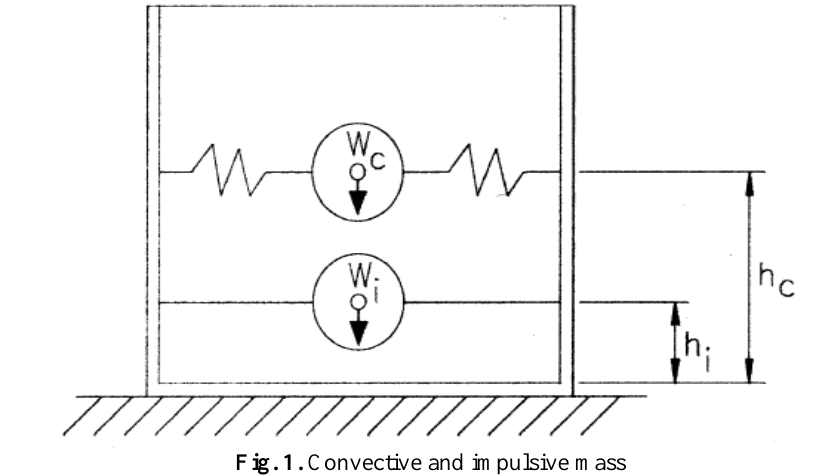
Fig. 1. Convective and impulsive mass